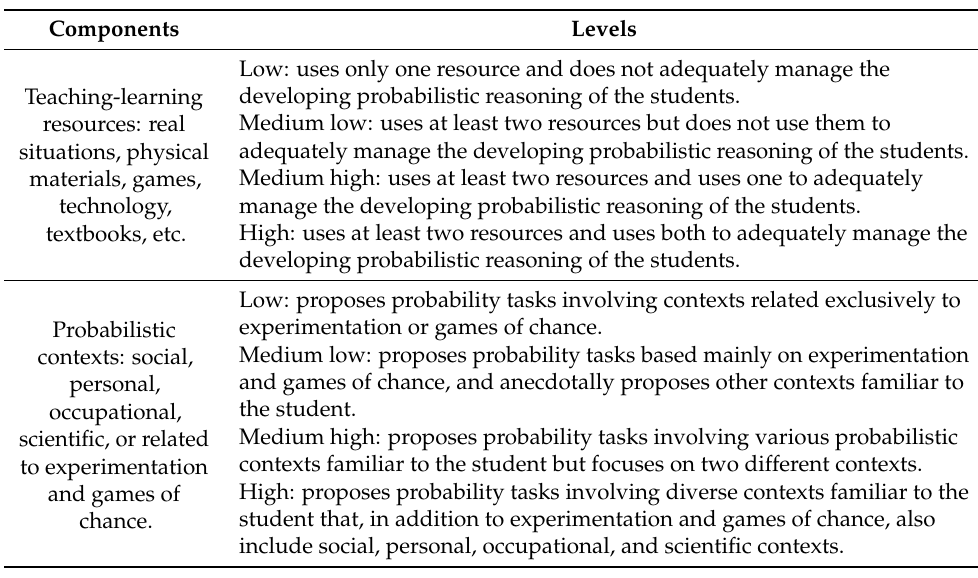
Table 3. Components and levels of the “probability tasks” dimension IOC-PROB (Adapted from